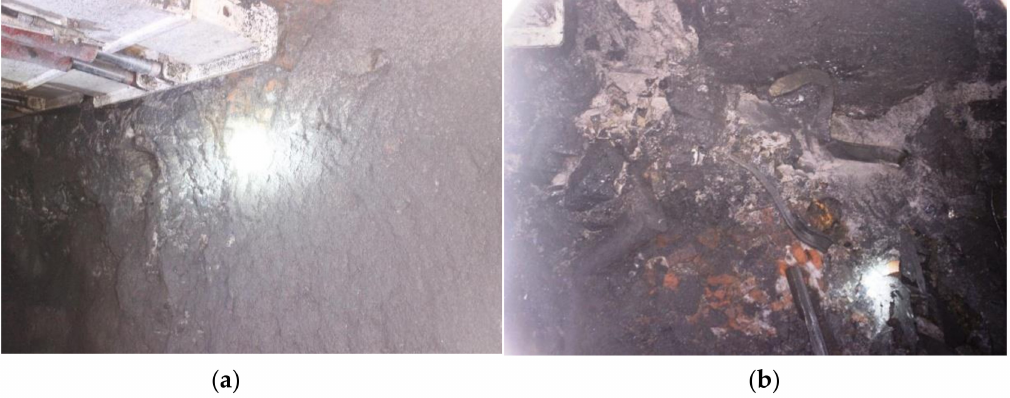
Figure 16. The rock mass exposed in the grouting area: ( a ) Coal wall; ( b ) Tip-to-face